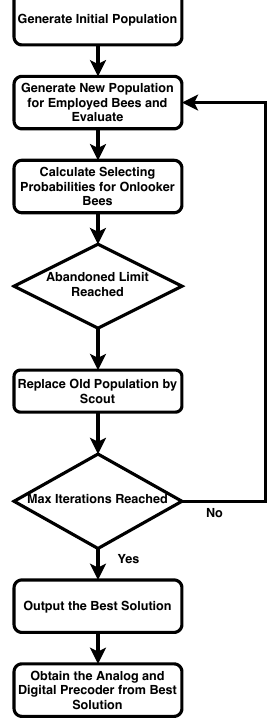
Figure 2. Flow chart of